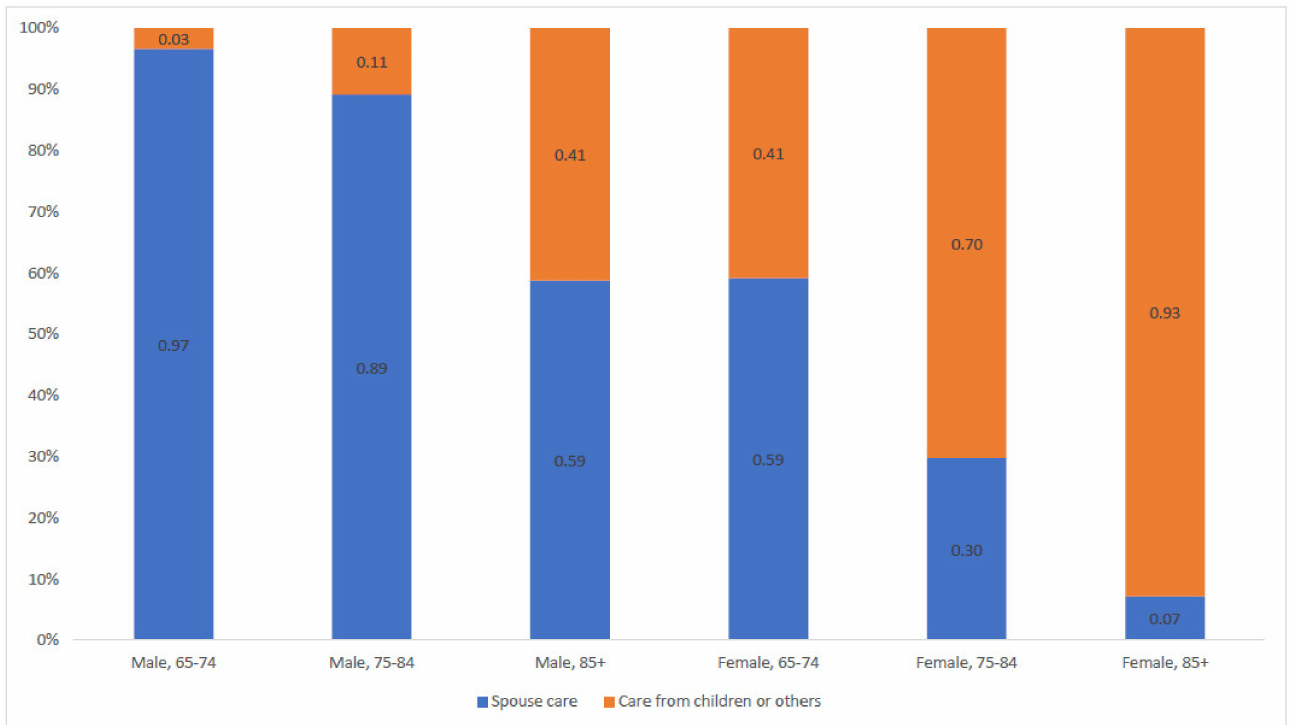
Figure 2. Predicted probability of receiving care from spouse or other family members by demo- graphic profiles among informal care recipients.